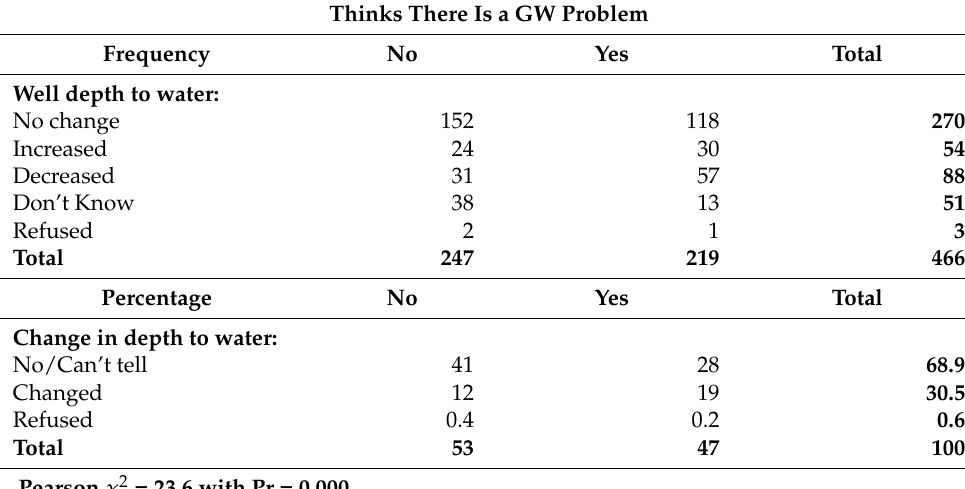
Table 10. Summary statistics of farmer perceptions and attitudes regarding changes in aquifer levels and presence of groundwater problems in the LMRB.